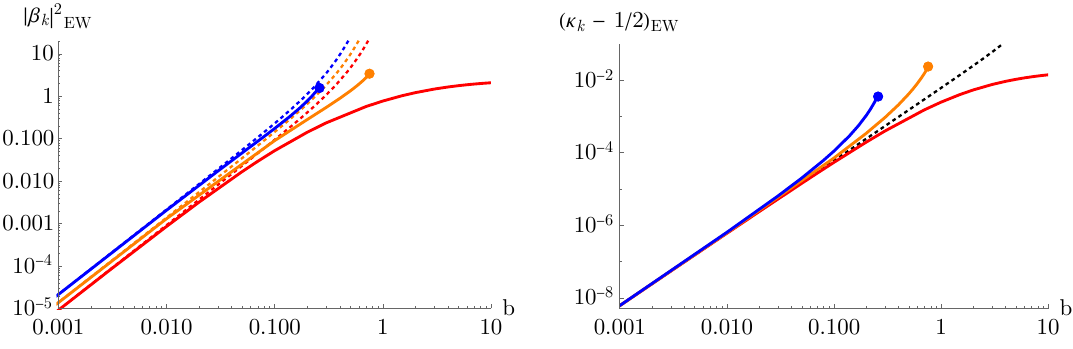
Figure 3 . Instantaneous photon number j (cid:12) k j 2 (left) and quantumness parameter (cid:20) k subtracted by 1 = 2 (right) at the electroweak phase transition, as functions of the beta function coe(cid:14)cient b . The results are shown for a wave number k=a 0 = (10 Gpc) (cid:0) 1 . The reheating temperature is (cid:12)xed to T reh = 100 GeV, while the in(cid:13)ation scale is varied as H inf = 10 14 GeV (blue solid lines), 10 6 GeV (orange solid), and 1 GeV (red solid). The endpoints of the curves show where the Landau pole bound is saturated (see text for details). The dashed lines show the analytic approximations derived for small beta functions: (4.15) for j (cid:12) k j 2 , and (4.14) for (cid:20) k